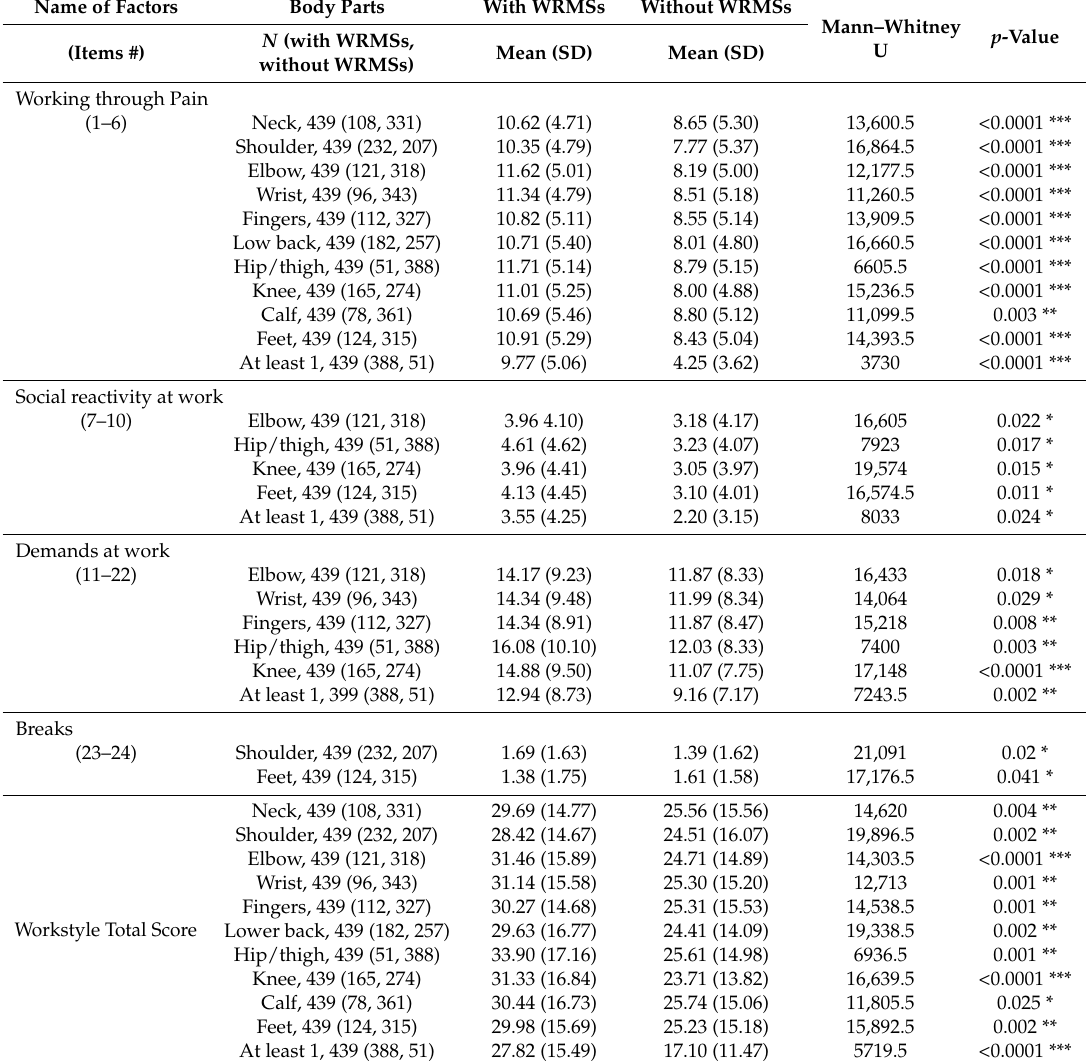
Table 3. Four factors identified from the factor analysis of C-WSF-24 items with a total variance of 56.5% and their known-groups validity to discriminate between NAs with WRMSs and without WRMSs in various body parts using the Mann–Whitney U test ( N =